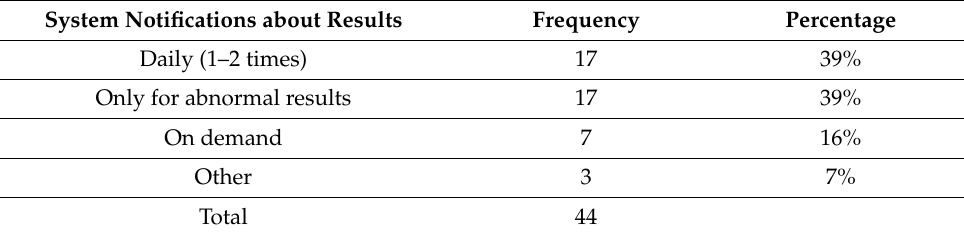
Table 6. System notifications for health measurements